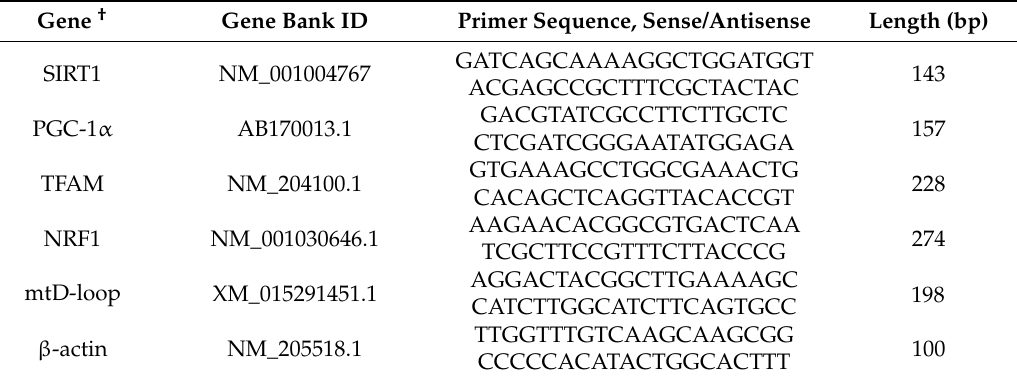
Table 2. Sequences for real-time PCR primers.